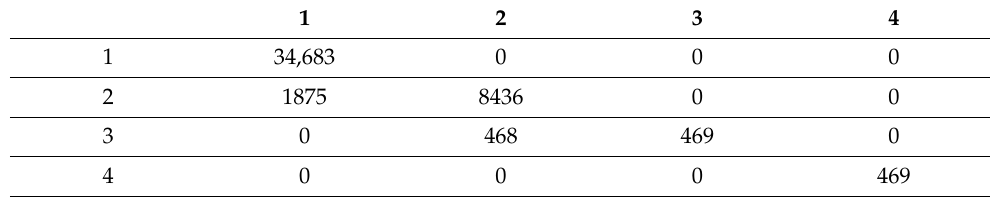
Table 4. The confusion matrix for RF.